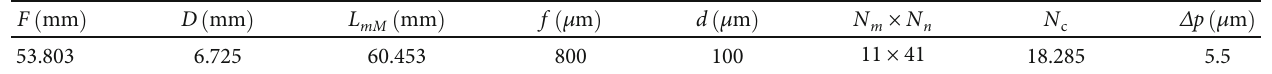
Table 2: The key parameters of the measurement system.